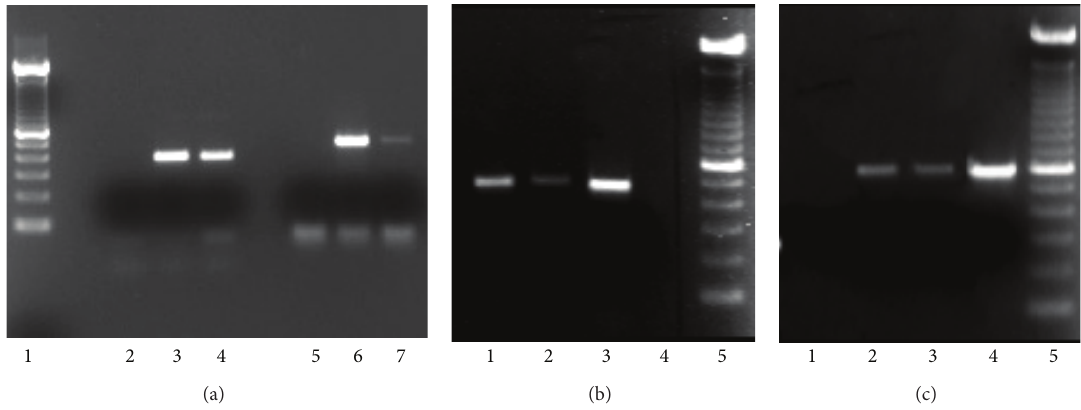
Figure 2: ET A and ET B transcripts amplified by RT-PCR in fibroblasts, CD4+ T lymphocytes, activated CD4+ T cells, and neutrophils. ET A corresponds to a molecular weight of 446 bp and ET B to a molecular weight of 558 bp. (a) ET A and ET B transcripts amplified by RT-PCR in fibroblasts and neutrophils. Lane 1: molecular weight ladder; lane 2: negative control; lane 3: fibroblasts (ET A ); lane 4: neutrophils (ET A ), lane 5: negative control; lane 6: fibroblasts (ET B ); lane 7: neutrophils (ET B ). (b) ET A transcripts amplified by RT-PCR in T lymphocytes, activated T cells, and fibroblasts. Lane 1: T lymphocytes; lane 2: activated T cells; lane 3: fibroblasts; lane 4: negative control, lane 5: molecular weight